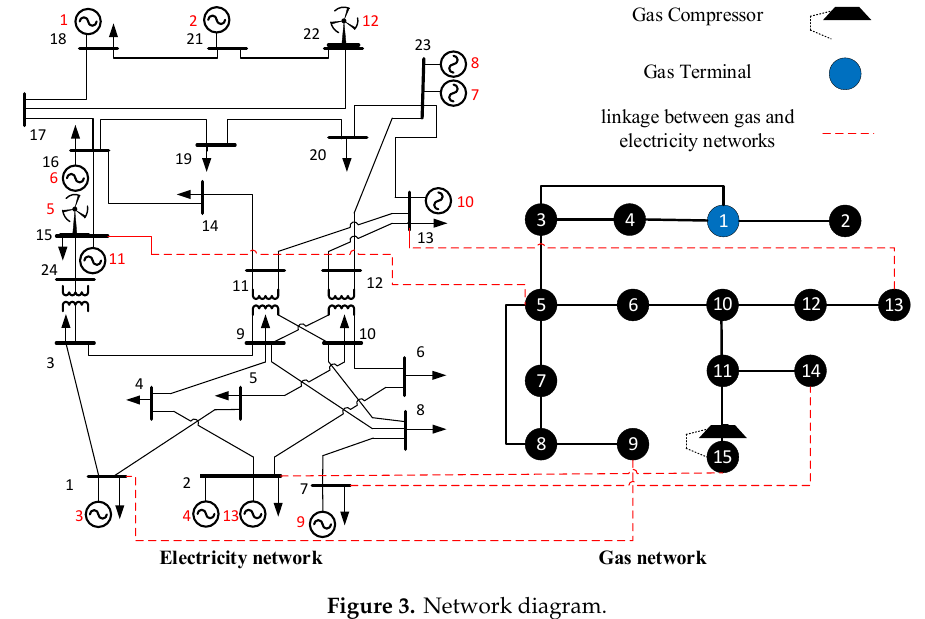
Figure 3. Network Figure 3. Network diagram.